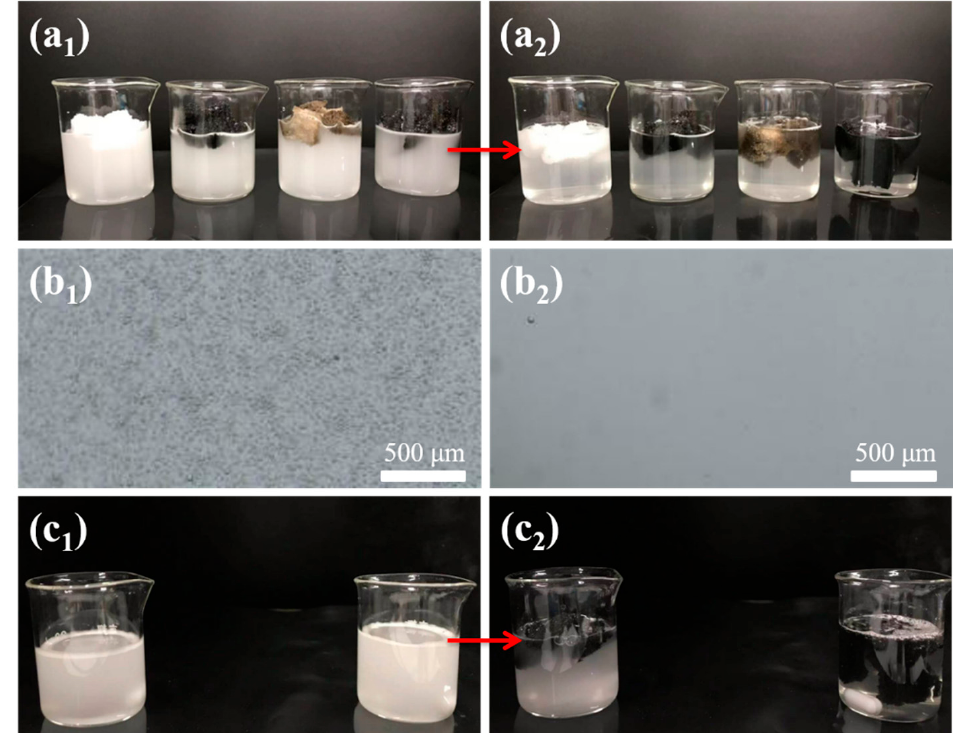
Figure 6. The separation of O/W emulsions under static ( a 1 , a 2 ) and dynamic ( c 1 , c 2 ) condition. The photos of PDMS, CNT-PDMS, PDA/PDMS, and PDA/CNT-PDMS sponges (from left to right) in toluene/water emulsion at 0 min ( a 1 ) and 40 min ( a 2 ), while ( b 1 ) and ( b 2 ) are corresponding optical images of emulsion. The photos of CNT-PDMS (left) and PDA/CNT-PDMS sponges (right) in toluene-in-water emulsion with magnetic stirring for 0 min ( c 1 ) and 5 min ( c 2 ).